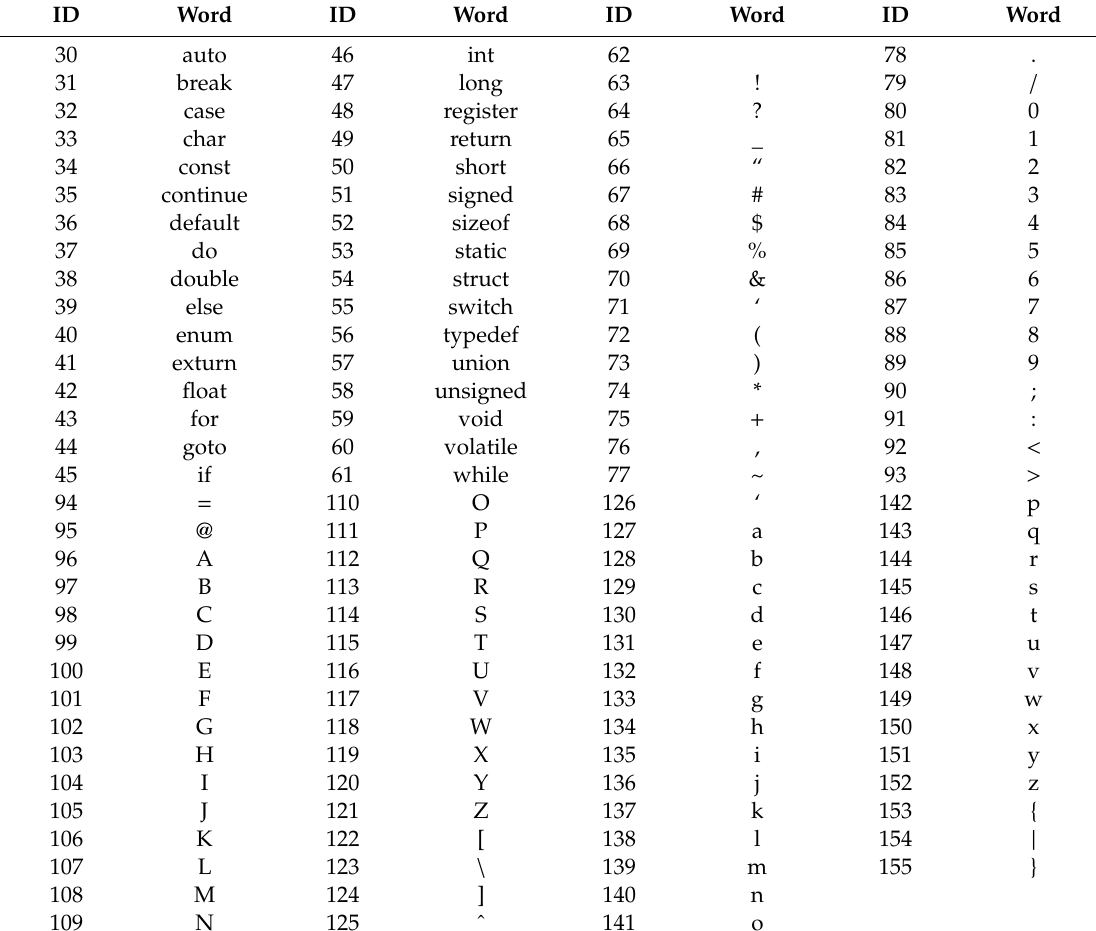
Table 1. Partial list of defined IDs for keywords, characters, and